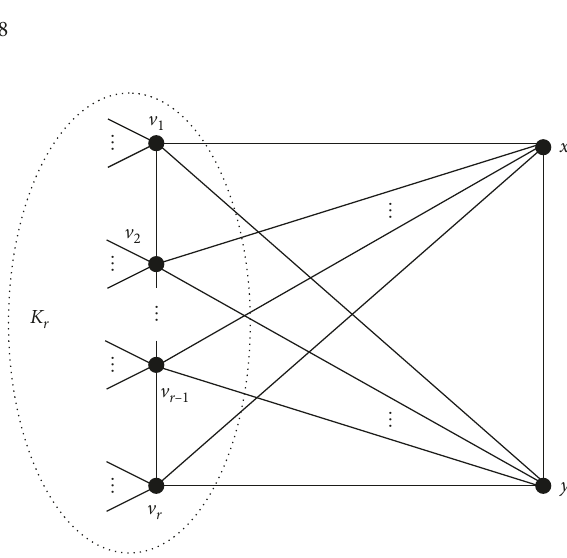
Figure 10: The graph K